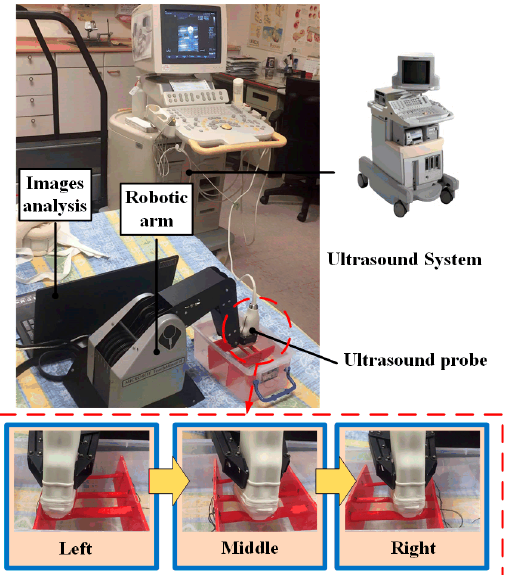
Figure 10. Pictures of the phantom test.